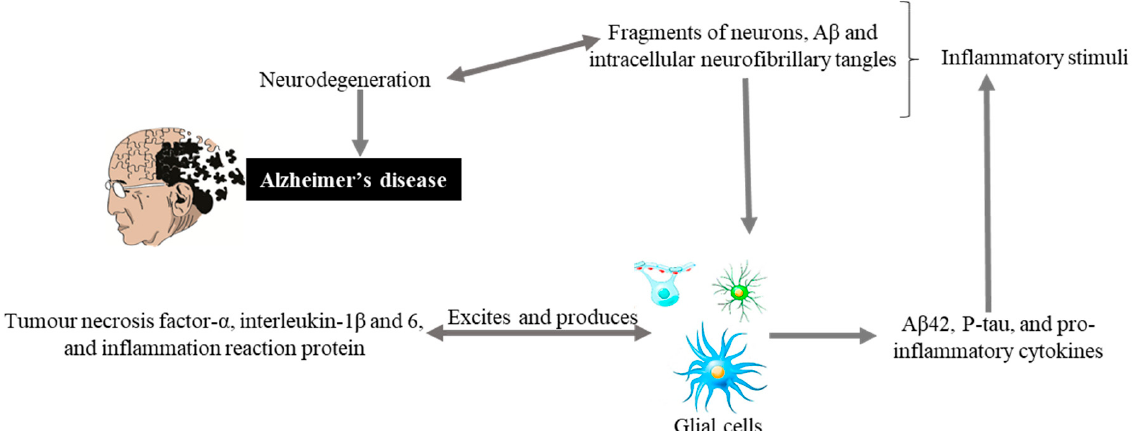
Figure 2. Hypothetical inflammation in AD. Inflammatory stimuli activate glial cells that produce tumor necrosis factor- α , interleukin-1 β and 6, and inflammation reaction proteins. These can also excite glial cells that produce A β 42, P-tau, and pro-inflammatory cytokines, and cycle is maintained that leads to neurodegeneration and Alzheimer’s disease.